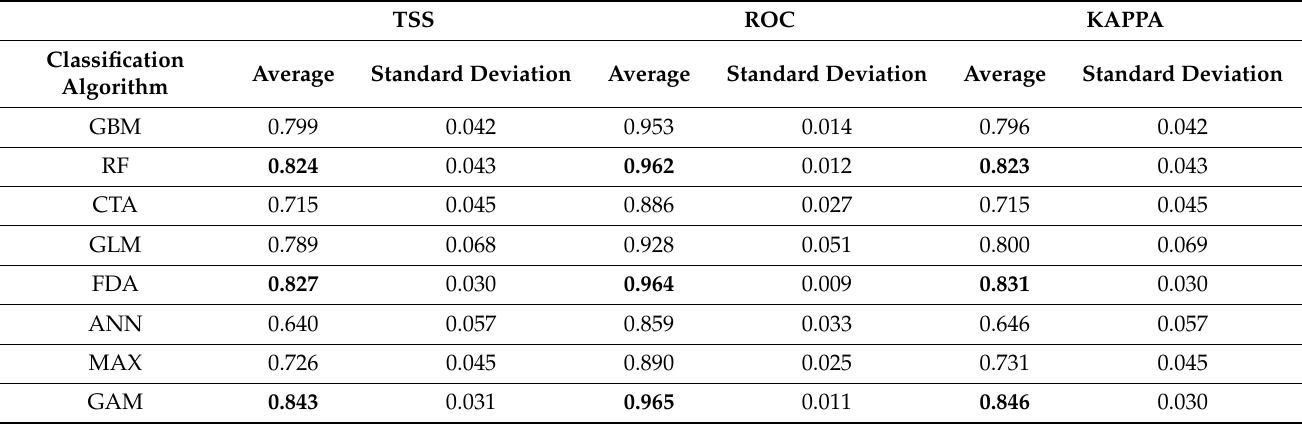
Table 3. Partial evaluation scores by classification algorithm showing the average and standard deviation (across evaluation rounds). Numbers in bold indicate the top-three algorithms in our study.